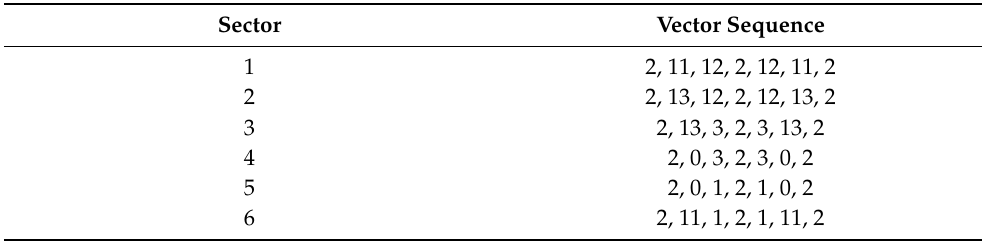
Table A3. Vector switching sequences of the second outer hexagon, by the ith designation (V i ).